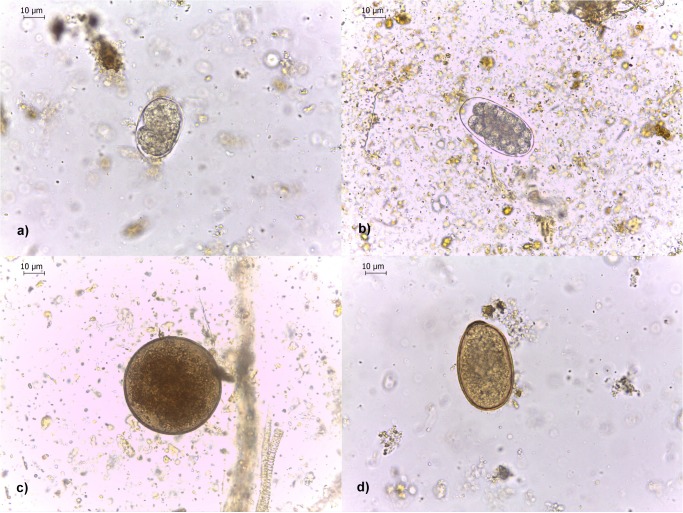
Photomicrographs of nematode eggs found in Galápagos giant tortoise faecal samples.(a) Small strongyle egg. (b) Large strongyle egg. (c) Ascarid egg. (d) Oxyurid egg. N.B. No trichurid eggs were found in samples returned to the laboratory for photography.